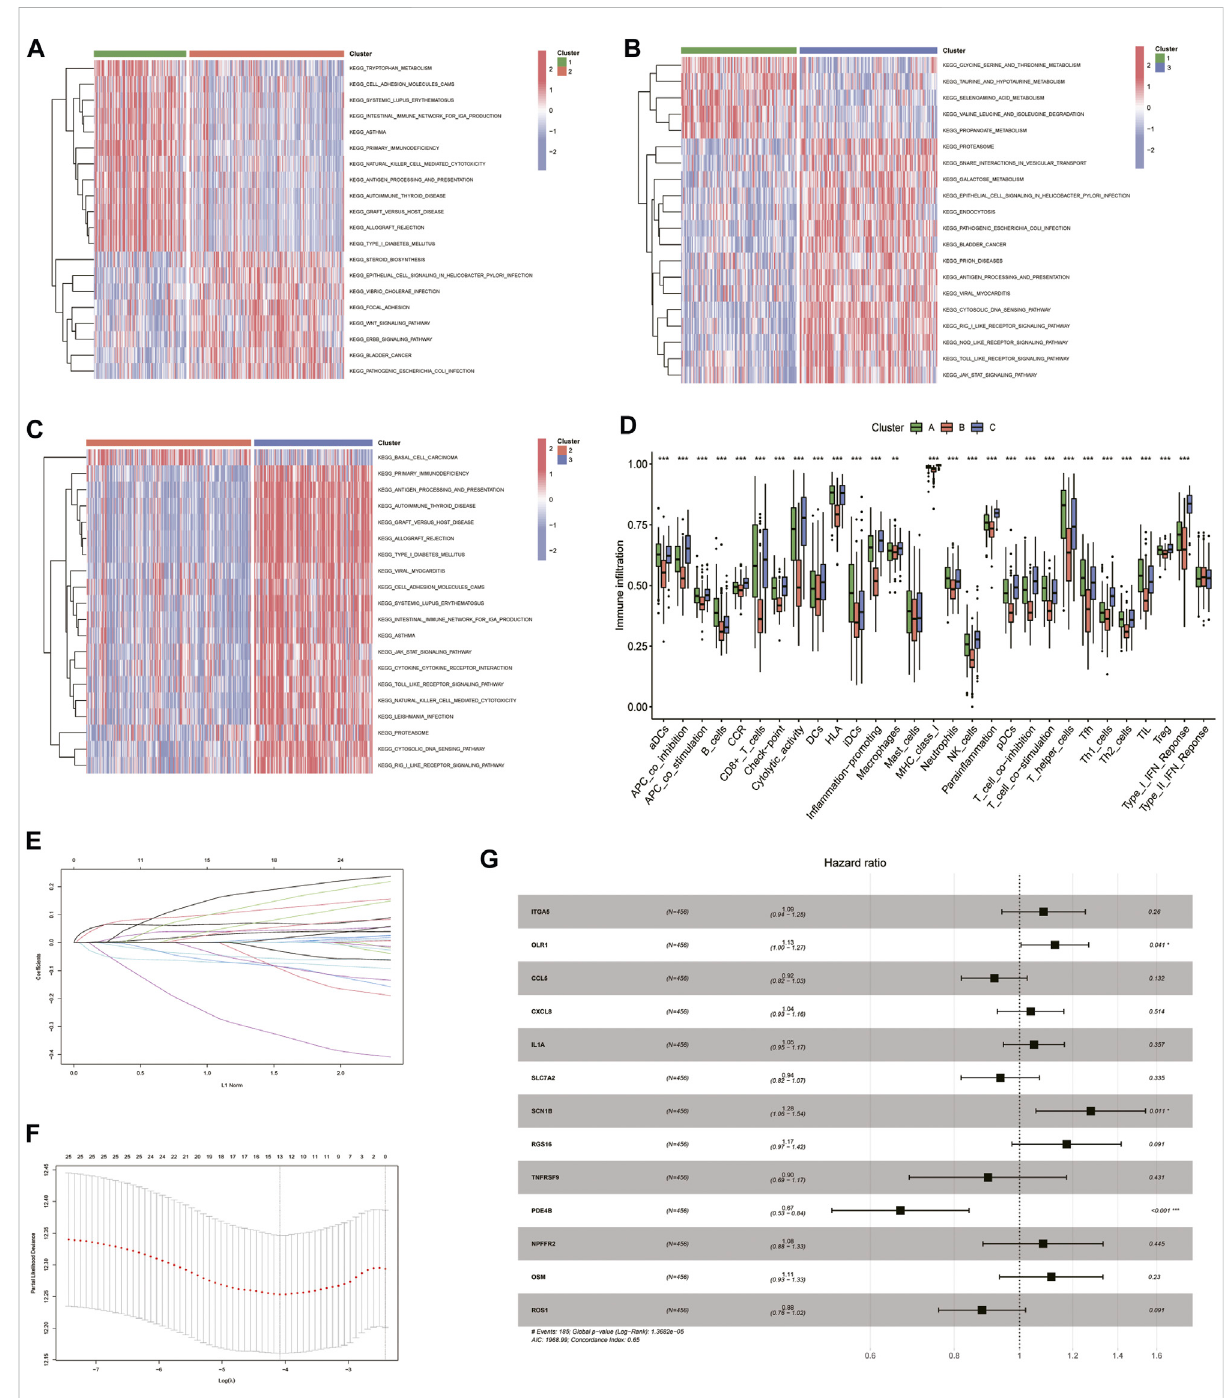
FIGURE 4 Univariate COX, lasso and multivariate COX regression analysis of overall survival-related in fl ammation-associated genes using R software. (A – C) Heat map showing differences in enrichment function between the 3 subclusters. (D) The degree of immune in fi ltration was assessed using ssGSEAandbox-lineplotsweredrawntodemonstrateimmunityindifferentsubclasses. (E) LASSOregressionanalysistocalculatethecoef fi cientsof in fl ammation-related genes. (F) Thirteen genes were selected as active covariates for cross-validation of LASSO mode. (G) Forest plot showing the 13 genes which were selected by stepwise forward and backward regression methods for the Cox proportional hazard